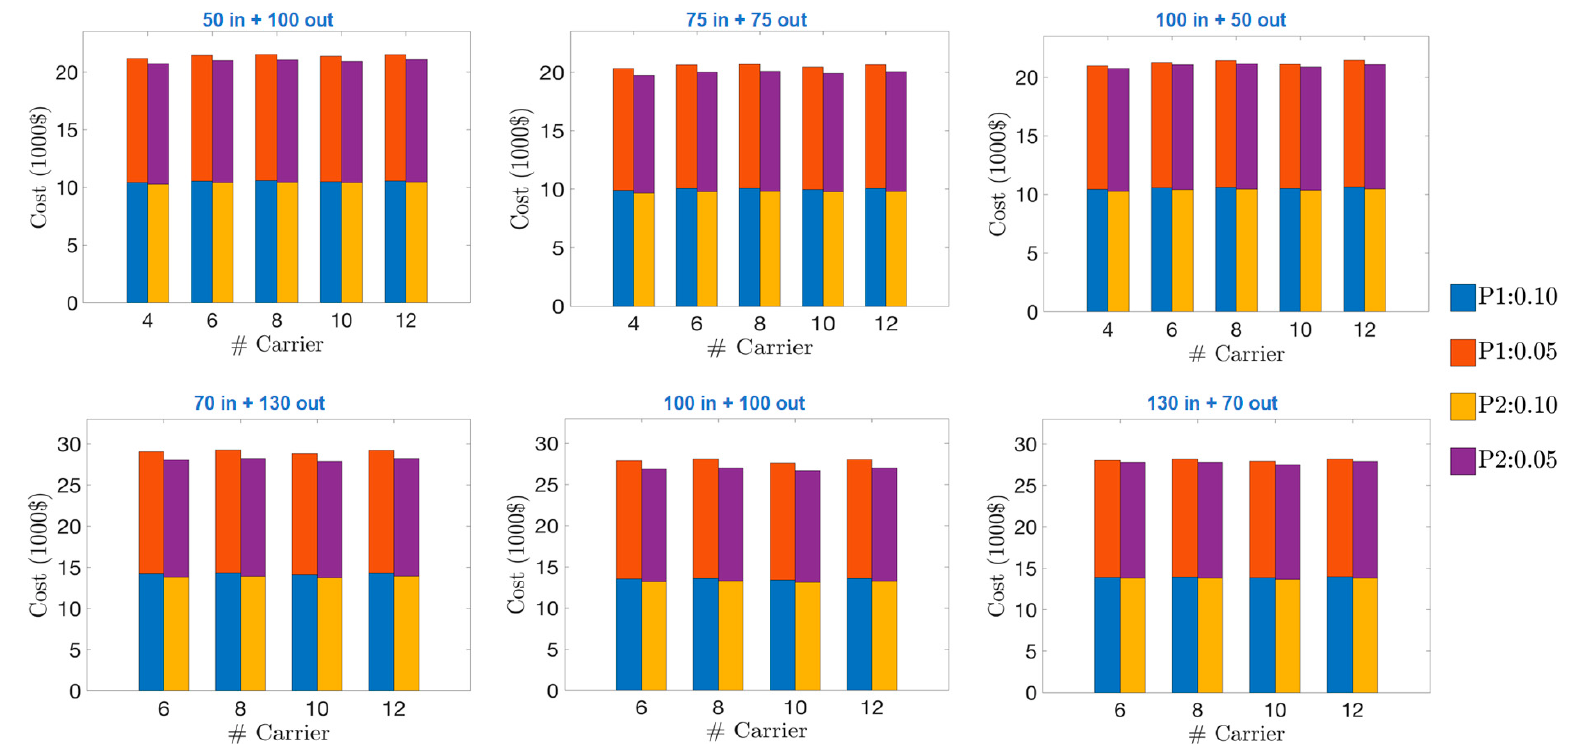
Figure 6. Carrier cost of 150 and 200 shipments under Propositions 1 and 2.